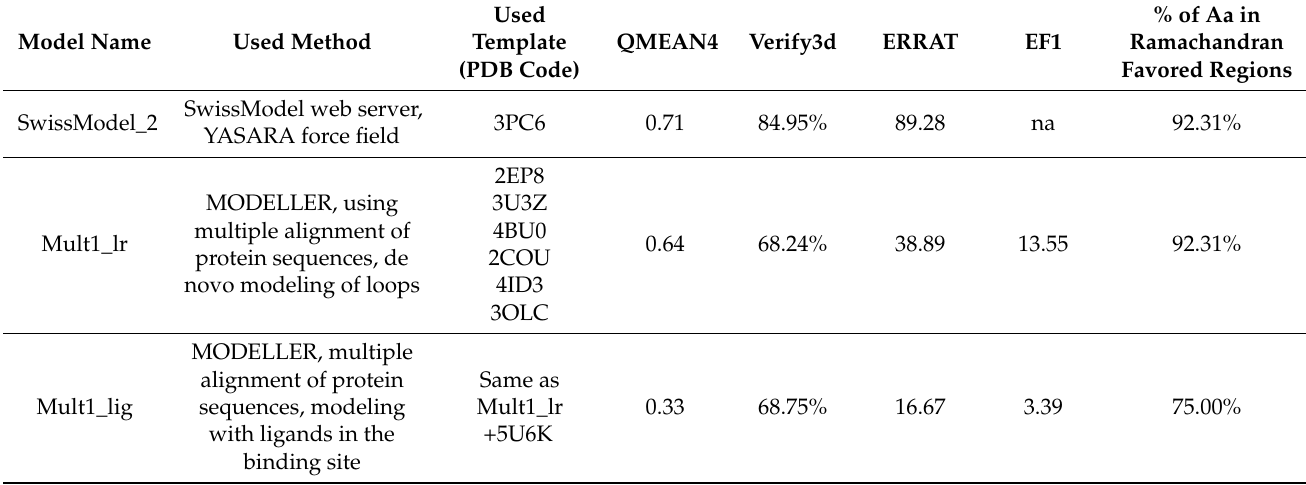
Table 7. Model evaluation indicated that Mult1_lr model performed the best at distinguishing decoys and known ligand compounds. Model name, used software, template, and quality parameters (QMEAN, Verify3d, ERRAT, and EF1) of the selected models were presented in the following table. Despite the performance of Mult1_lr, the best scoring model (best parameters in everything but EF1) was swissmodel_2.